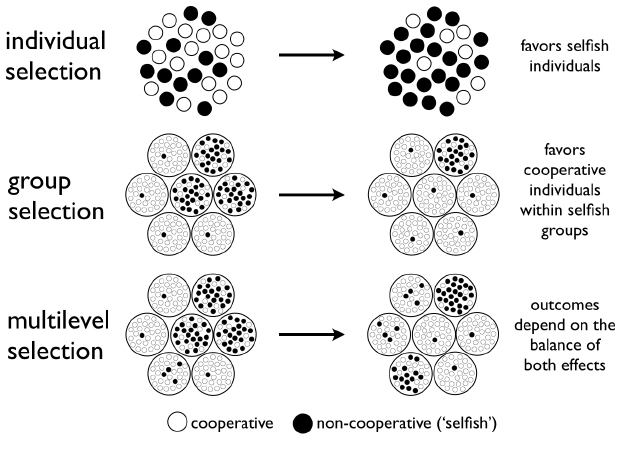
Fig. 1 . A simplified graphical model of multilevel selection. In social dilemmas, outcomes depend on the level of organization on which selection operates most strongly. To determine the dominant level of selection, the direction and magnitude of selection at the relevant levels should be estimated and